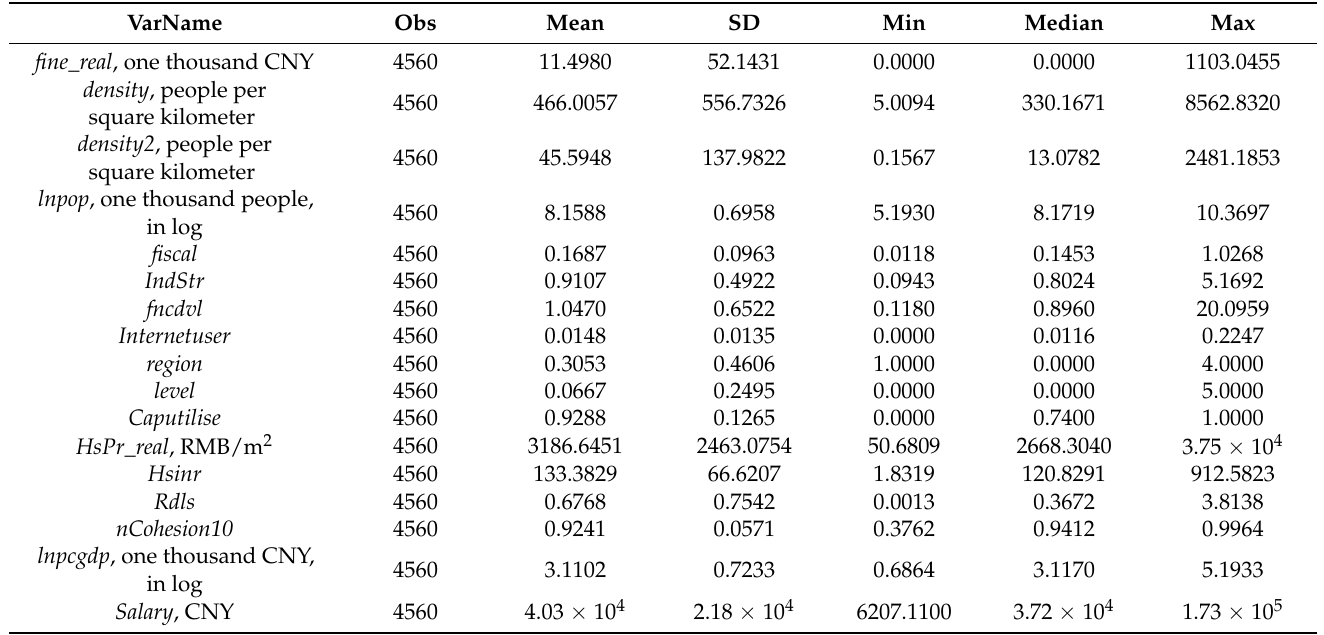
Table 1. Descriptive